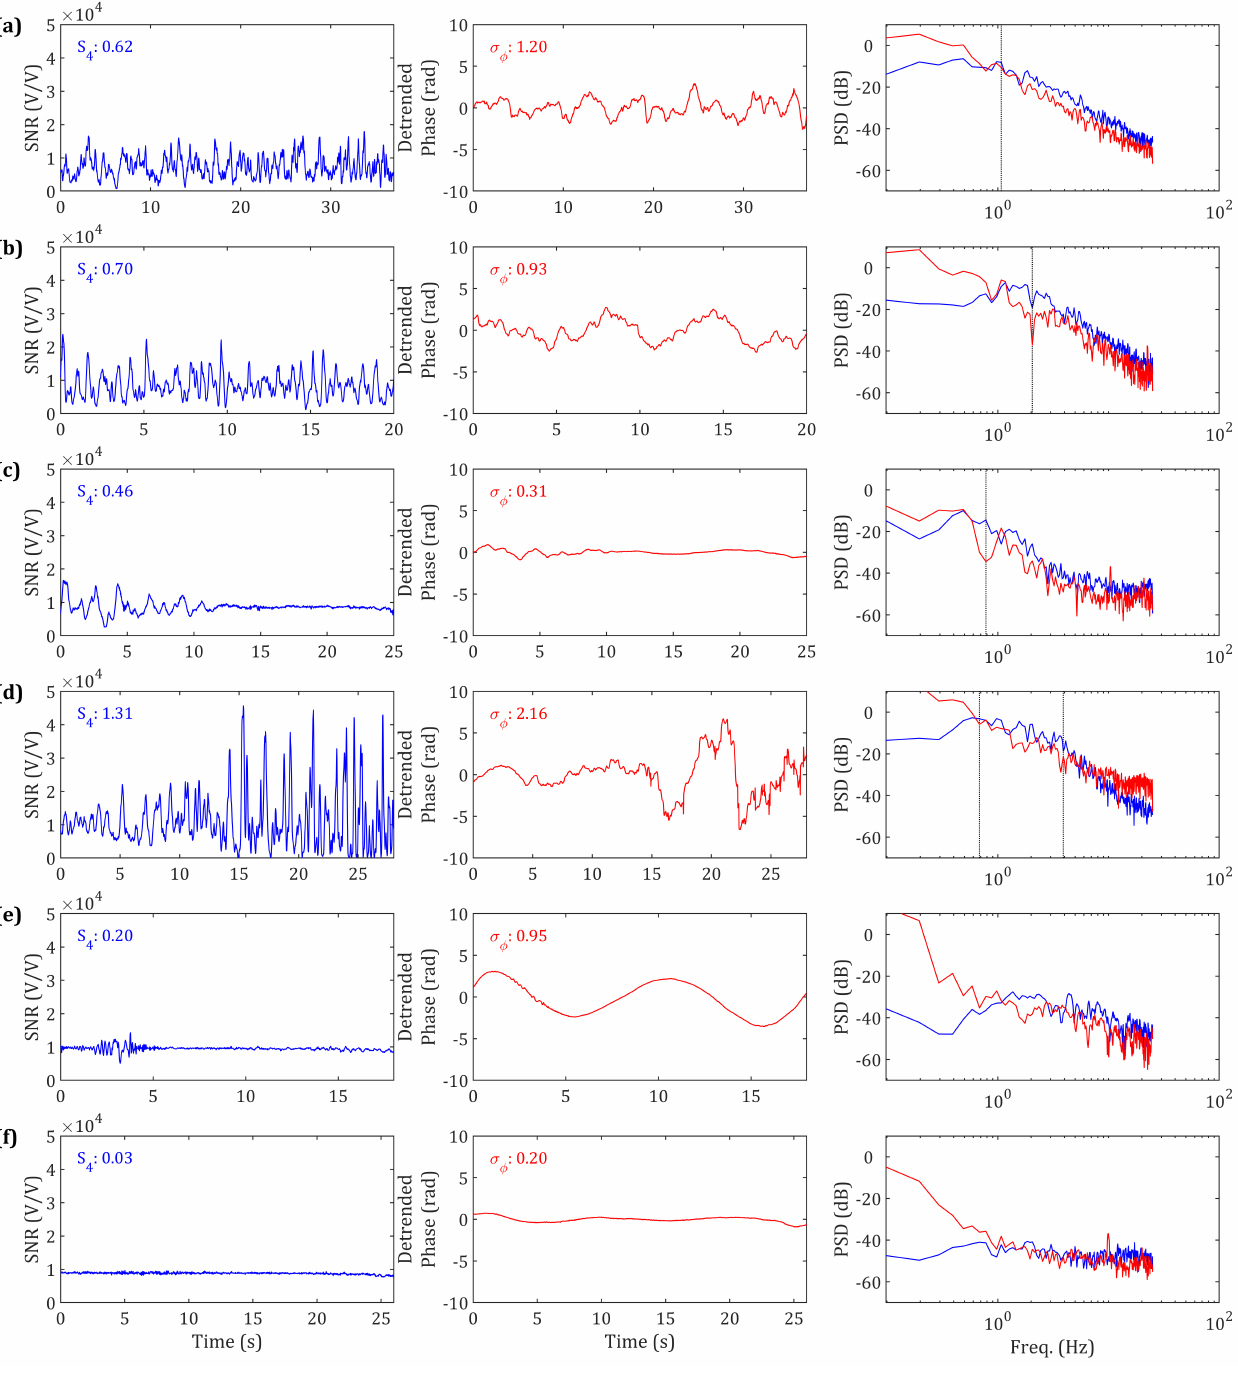
Figure 1. SNR, detrended excess phase, and intensity and phase PSDs. Blue and red curves are related to SNR, excess phase and their power spectra, respectively. MetOp measurements ( a ) MTPB.2015.079.03.41.G29, ( b ) MTPB.2015.079.01.58.G13 and ( c ) MTPB.2015.079.01.51.G19 show a monotonic power law in intensity and phase PSDs; ( d ) MTPB.2015.079.03.49.G23 depicts an apparent two-component power law in the intensity PSD, with phase PSD following a different trend at the high-frequency end; and ( e ) MTPA.2015.076.11.31.G07 and ( f ) MTPA.2015.077.03.17.G01 correspond to inconclusive cases or measurements not affected by disturbances in the SNR and detrended phase. Vertical lines show possible spectral breaks ( f b